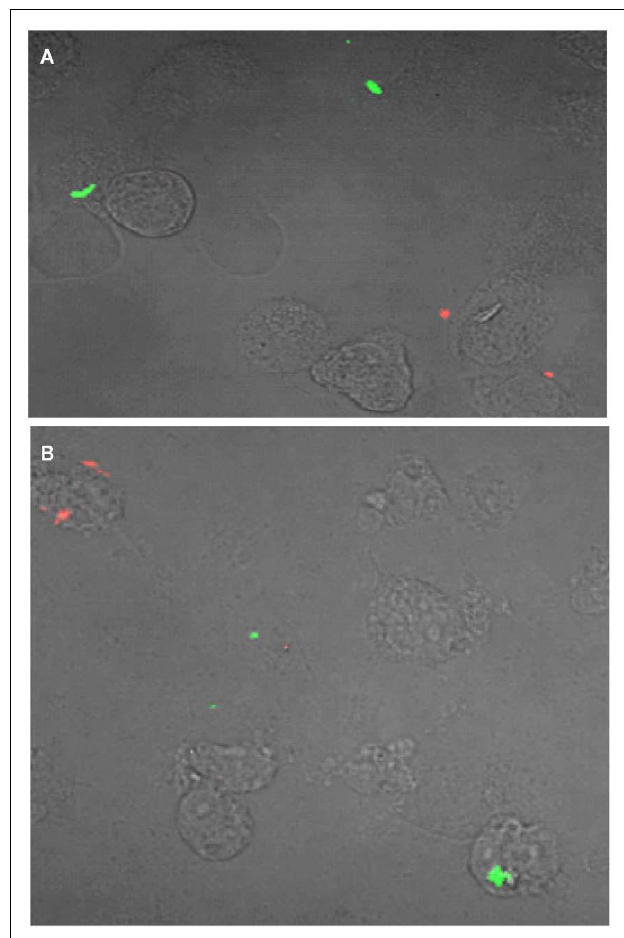
FIGURE 4 | esxK L mutant and wild-type bacteria do not inhabit the same cells during low MOI co-infection. A representative confocal microscopy image ofTHP-1 cells simultaneously infected with equal proportion of fluorescently labeled wild-type (red) and Δ esxKL mutant (green) at MOI of 1:1 is shown. Cells were infected and fixed at (A) 24h, and (B) 72h post-infection as described in Section “Materials and